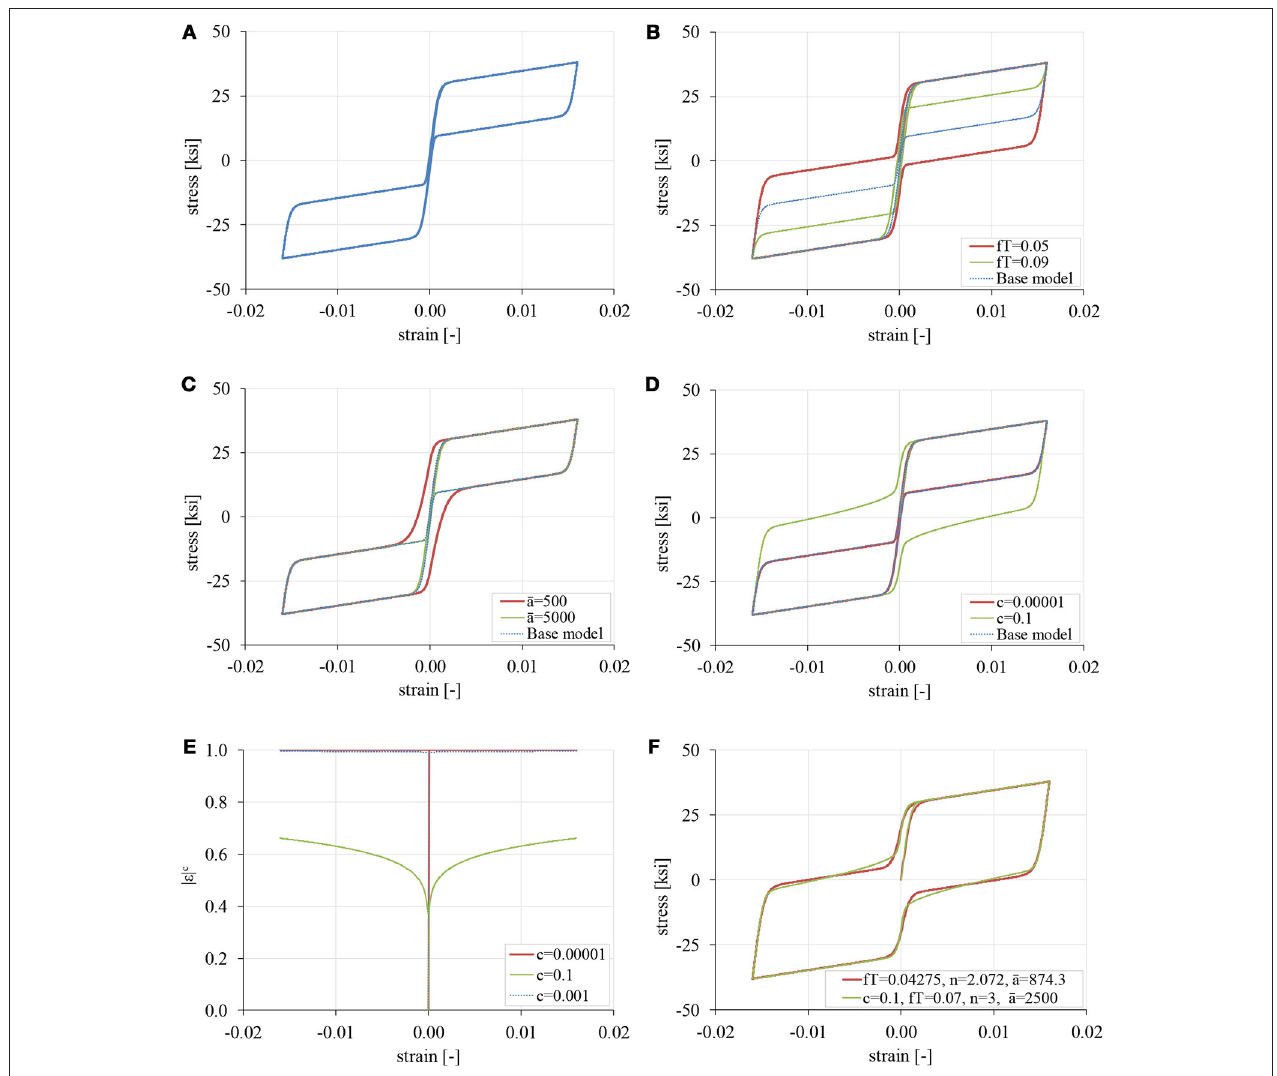
28,500 ksi, Y 30 ksi, α 0.0197, n 3, f T 0.07, ¯ a 2,500, c = = = = = = = 0.1 by altering f T , n, =